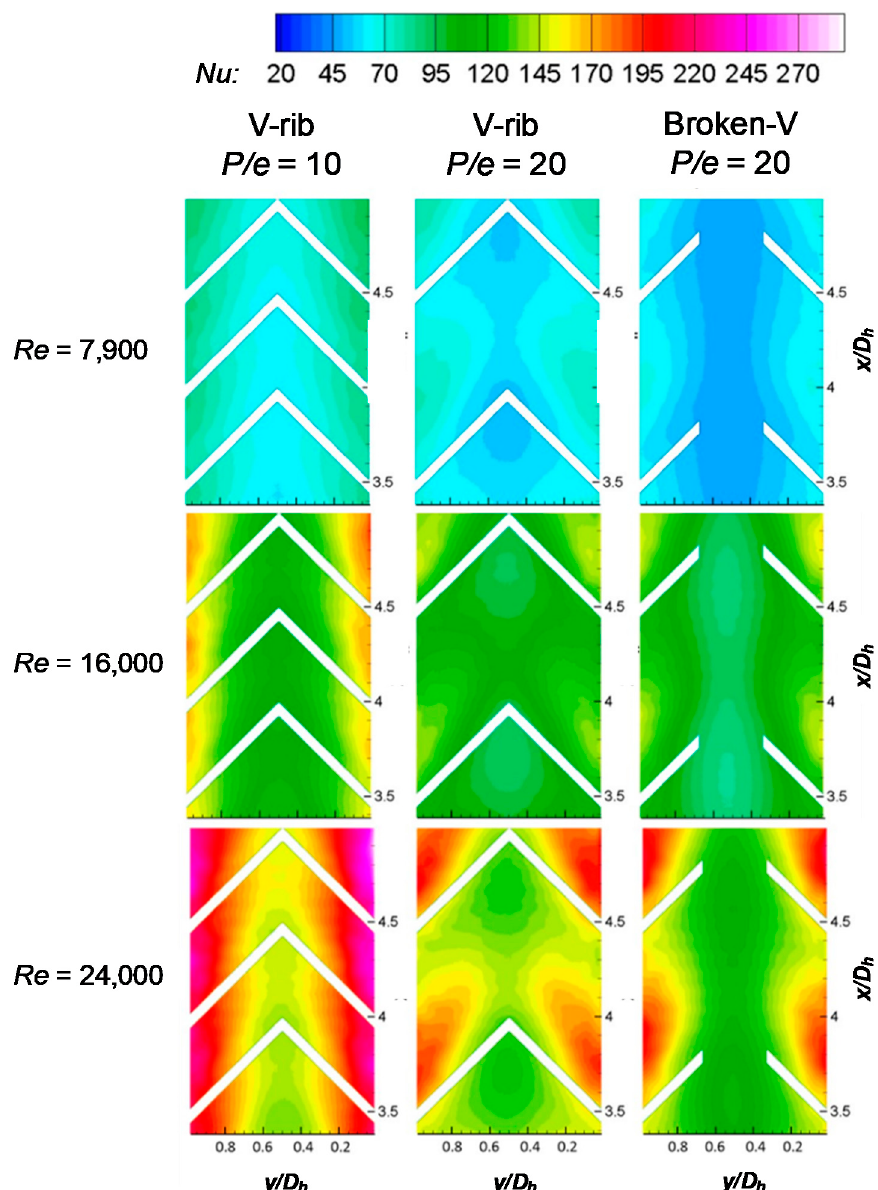
Figure 6. Nusselt number distribution for the air flow.